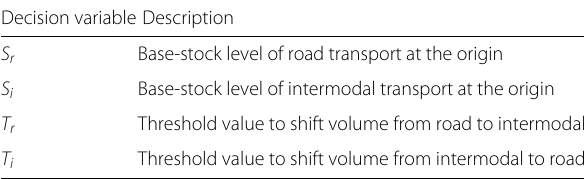
Table 1 Decision variables of our model